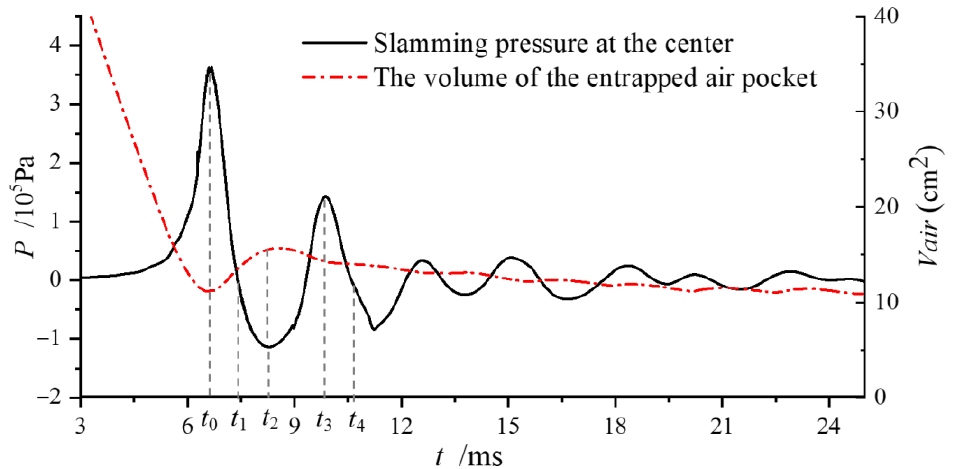
Figure 7. Slamming pressure in the bottom center of the plate.